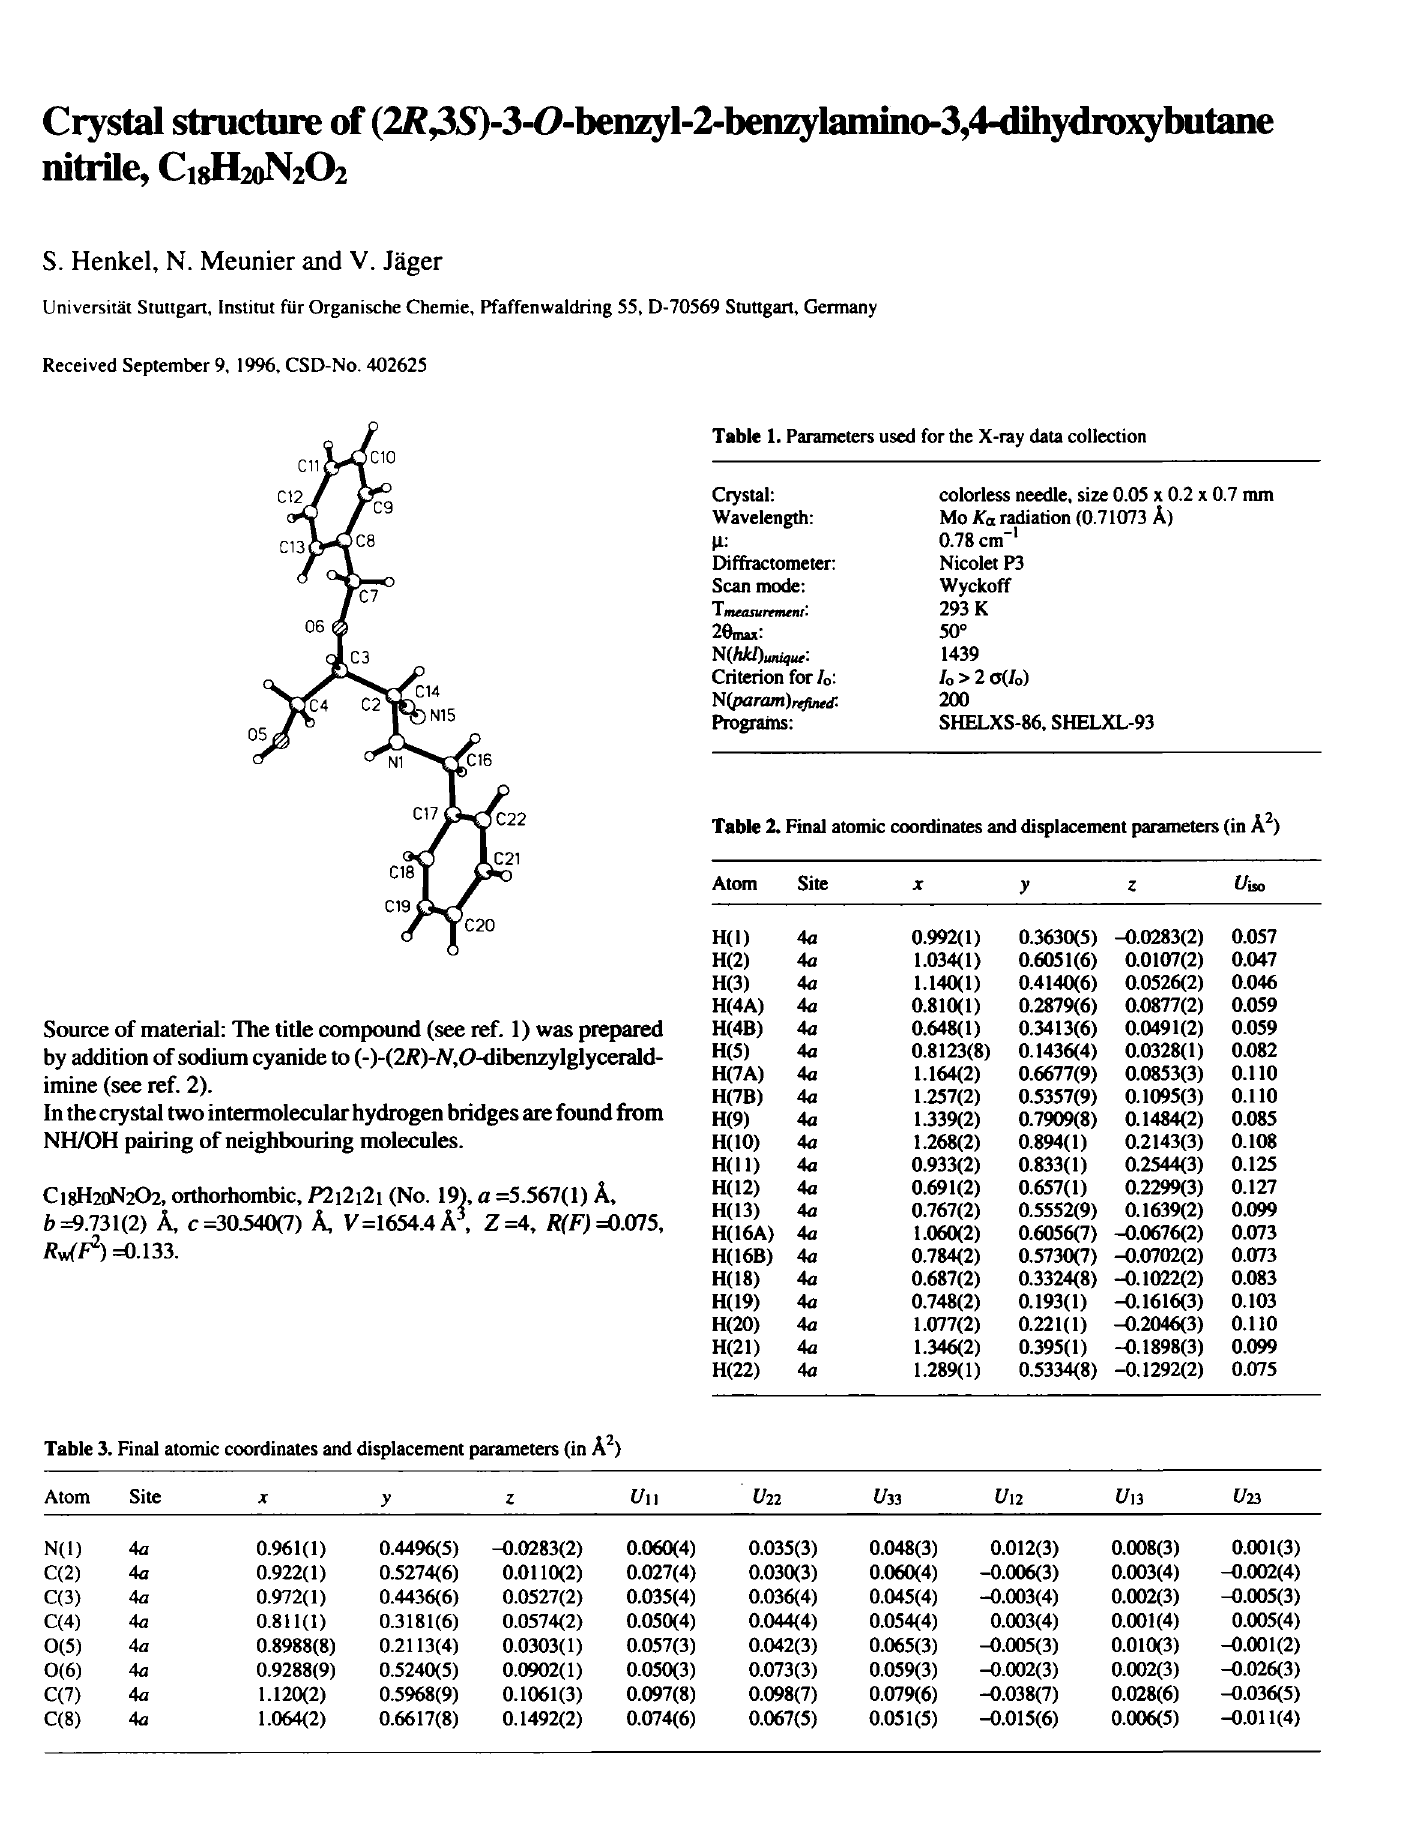
Table 1. Parameters used for the X-ray data collection